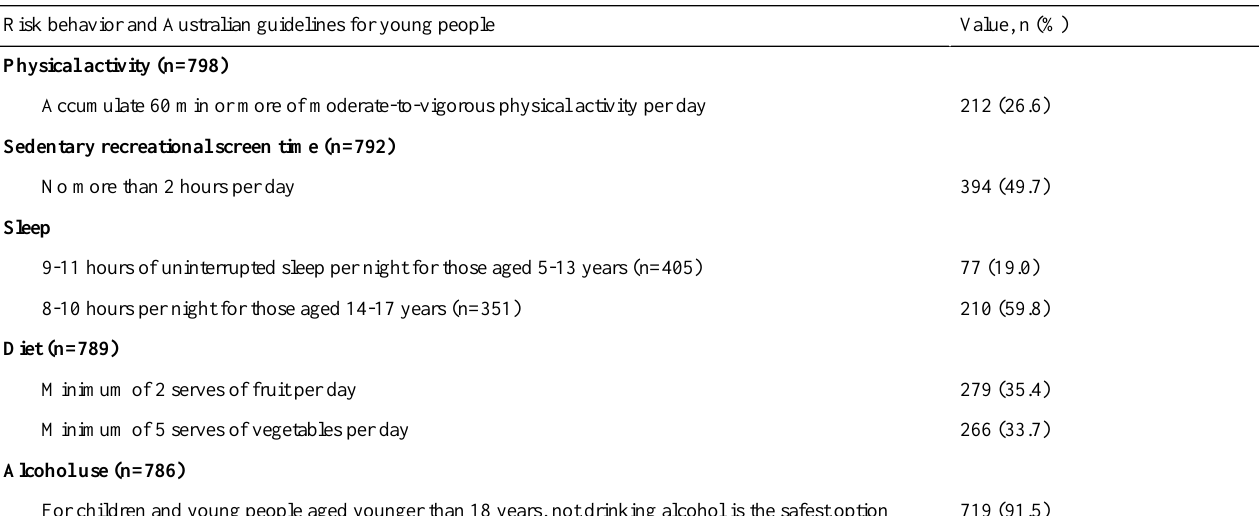
Table 2. Percentage of students who correctly identified national